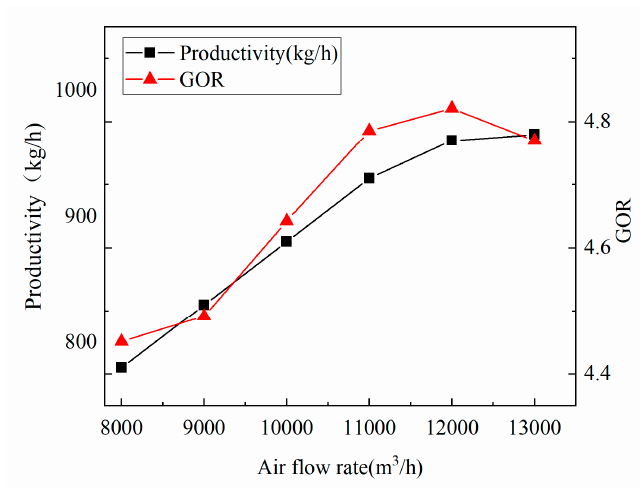
Figure 6. Effect of air flow rate on system productivity and GOR.